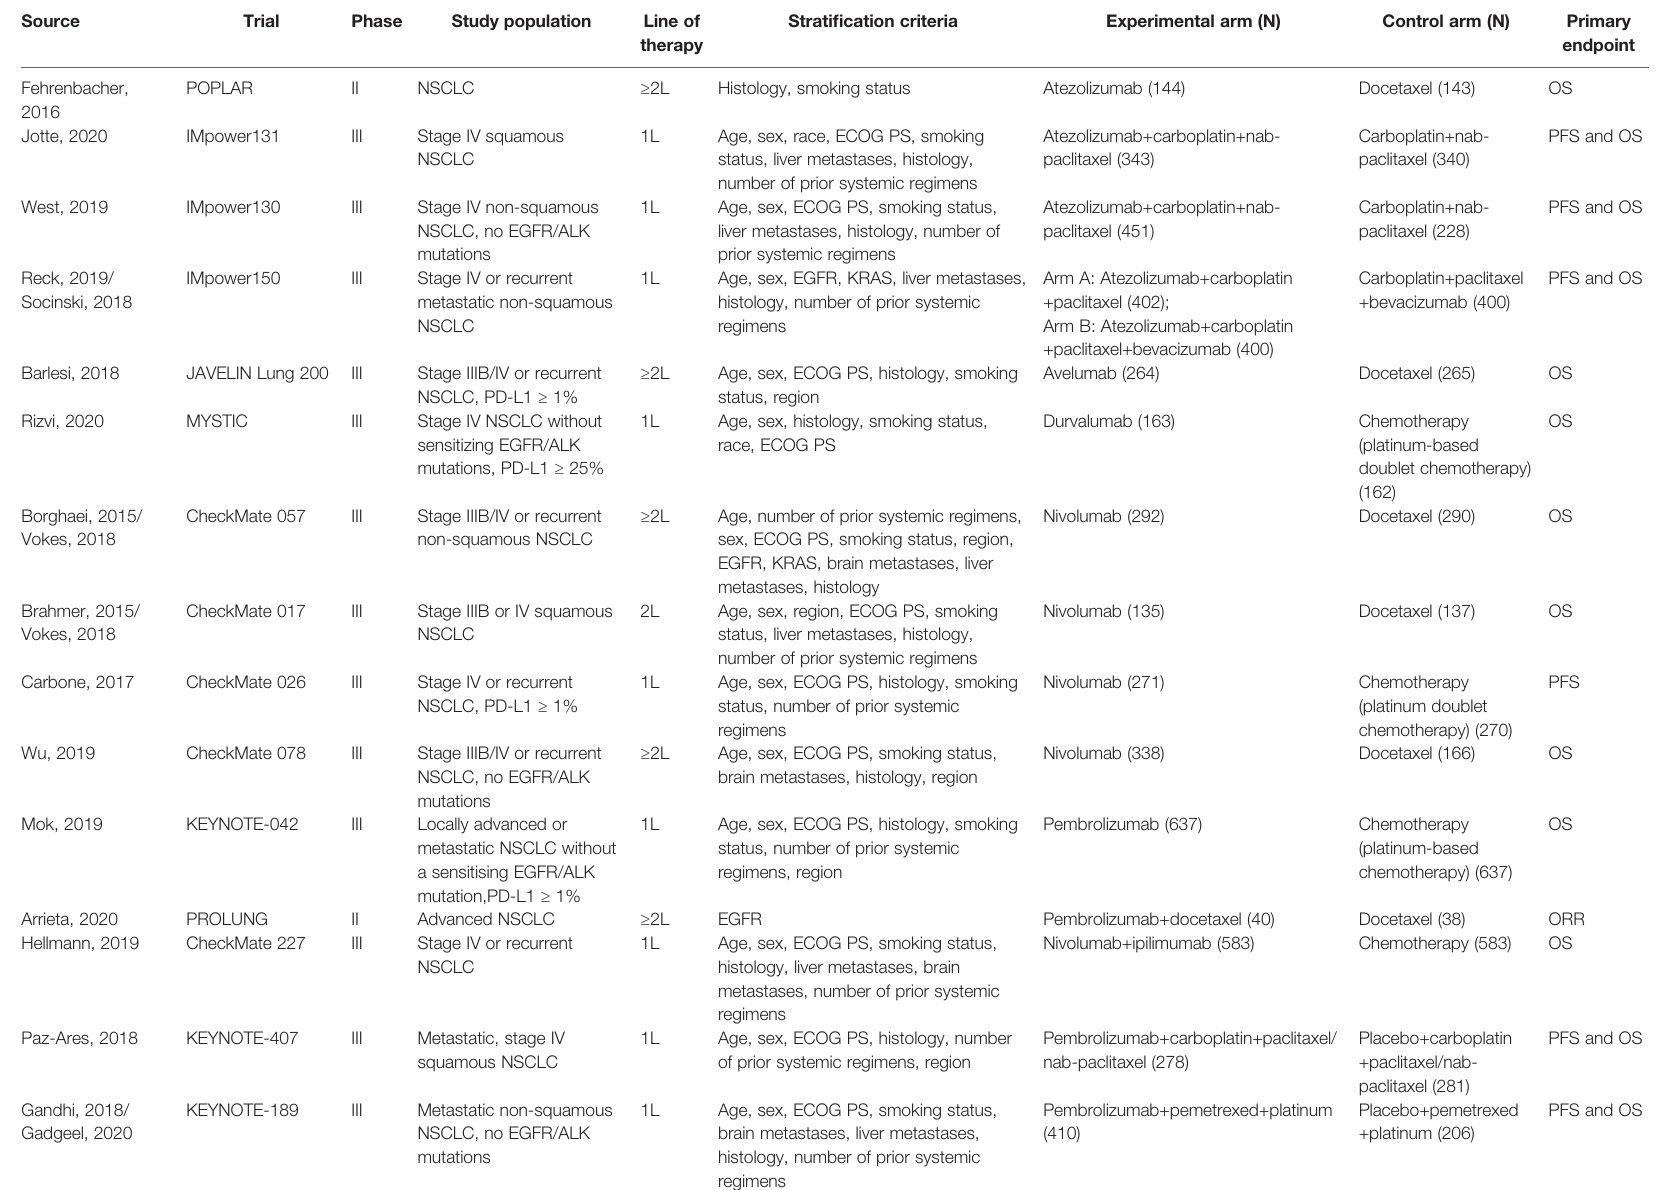
TABLE 1 | Study characteristics of included randomized controlled